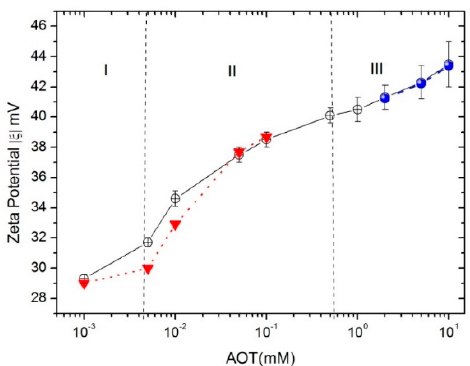
Figure 5. Zeta potential of PS at different AOT concentrations. The particle concentration was 0.01%, and the particle size was 535 nm. Black solid line and symbol indicate measured values. Red dotted line and symbol indicate calculated values below the CMC. Blue dashed line and symbol indicated calculated values above the CMC. CMC: Critical micelle concentration.